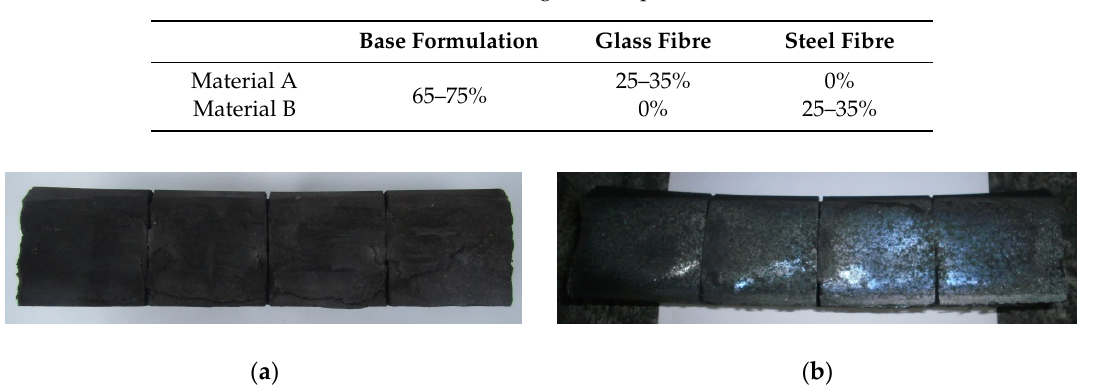
Figure 1. A full-scale inertia dynamometer for testing of brake friction pairs at the Railway Research Table 2. Formulation of the organic composites, wt% [31,32]. Institute in Warsaw ( a–c ) (pictures courtesy of the Railway Research Institute in Warsaw) and ( d ) 1xBg railway tread brake configuration, ( e ) scheme of the test rig with main components: 1 — electric motor; 2 — drive shaft; 3 — flywheels; 4 — railway wheel; 5 — brake block; 6 — brake cylinder; 7 — load cell.